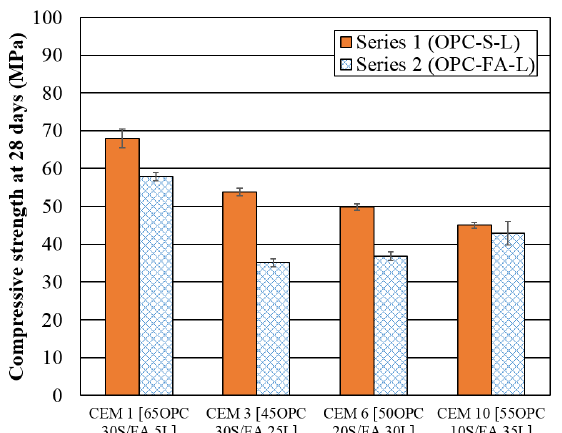
Figure 3. Compressive strength at 28 d for concretes with w/c of 0.45.